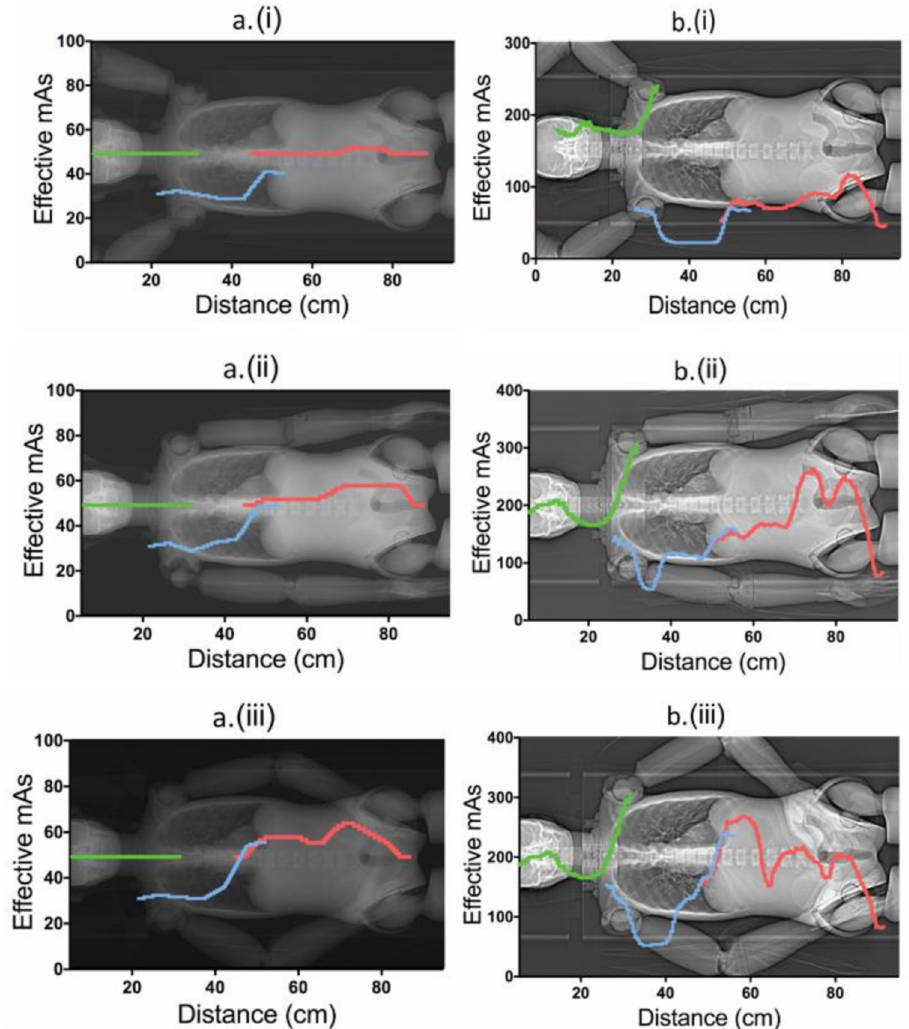
Figure 4. Effective mAs for the three different helical scans in different scenarios of arm positioning in the localizer radiographs (using corresponding protocol at both CT systems): (i) arms raised above the head, (ii) arms lowered along the trunk and (iii) arms along the trunk with hands placed on the abdomen, for Canon Aquilion One (( a ); left column) and Siemens Definition AS (( b ); right